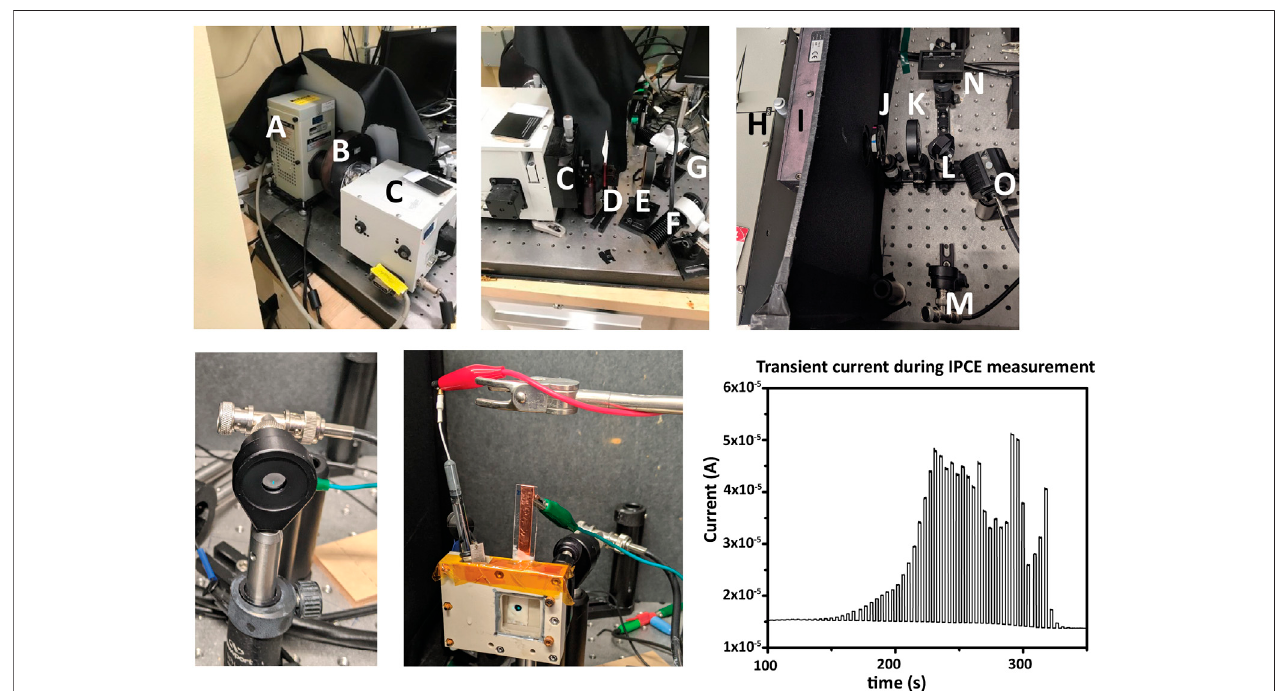
FIGURE 11 | IPCE measurement. Top row, two examples of instrumentational setup. (A) a Xe arc lamp, (B) computer-controlled shutter for generating light/dark conditions, (C , H) monochromators, (D , I) second-order fi lter(s) (E , K) lenses to focus monochromatic light to an under fi lled spot on the sample, (F , O) high-power LEDs for applying bias light, and (G , N) the sample locations. Also shown is the option of using a mirror (L) to alternate directing the monochromatic light from the PD (M) and the sample (N) . An iris (J) can restrict or increase the total light intensity if needed. A dark box or enclosure surrounding the light path from the monochromator aperture to the sample is required to eliminate stray light from the measurement. Bottom row: at the start of each IPCE measurement, the photodiode current is measured to determine monochromator spectral output for the under fi ll spot. The under fi lled spot is then aligned to the photoelectrode in the electrochemical cell, and bias lights and any electricalbiasareset. Chronoamperometry isthen measured simultaneously withthe wavelength scan. Lightand darkmeasurementscan beshown during acquisition in the form of a transient photocurrent graph.